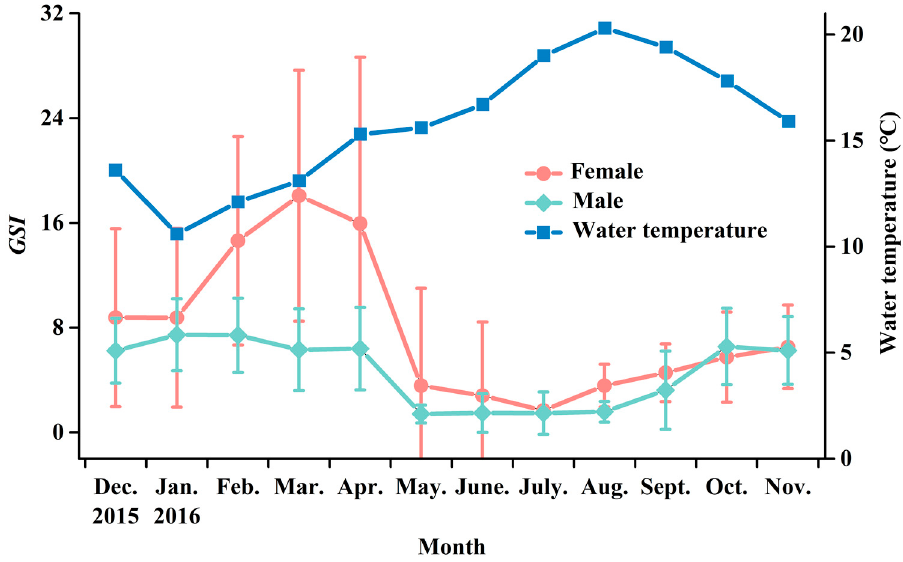
Figure 5. Monthly variations of GSI of G. tibetana and mean water temperature in the lower Yarlung Tsangpo River from December 2015 to November 2016. Error bars represent the standard deviations.